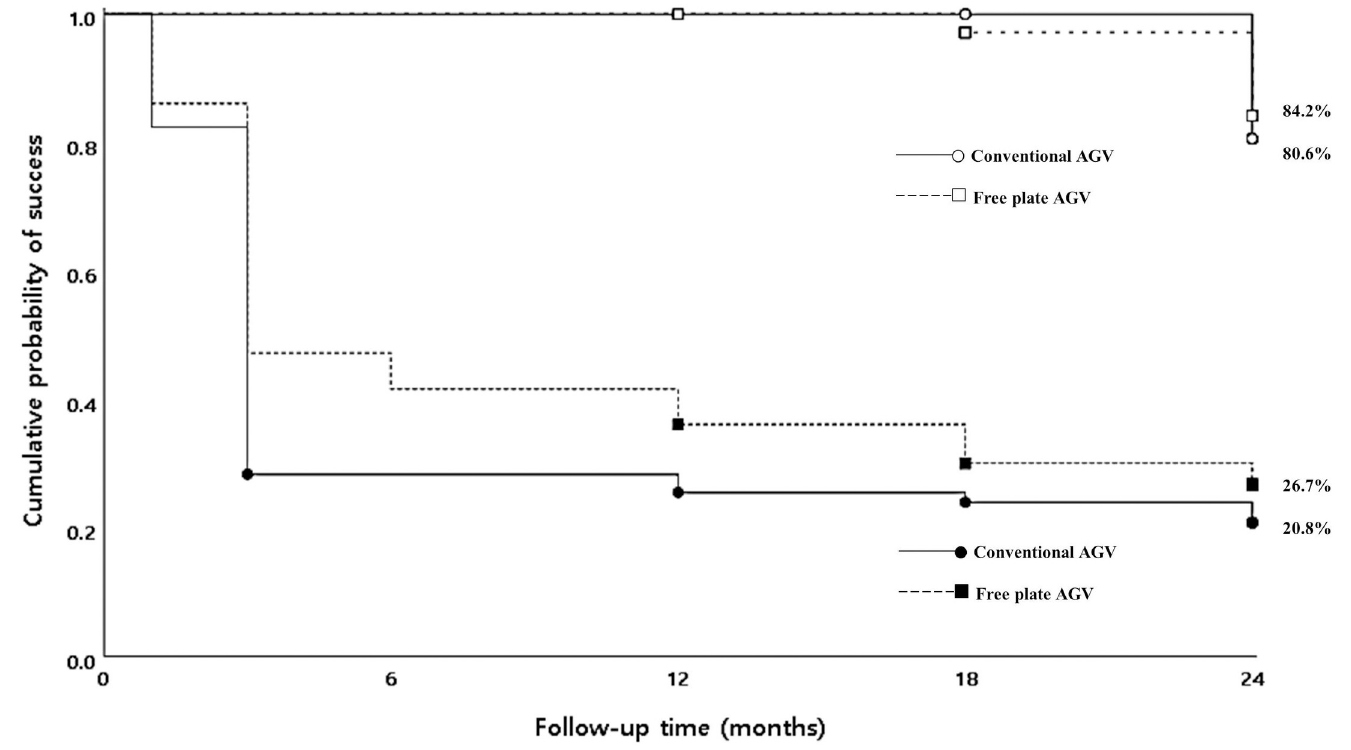
Fig 2. Kaplan–Meier survival curves showing the success rates of the conventional Ahmed glaucoma valve (CAGV) group and the free-plate Ahmed glaucoma valve (FPAGV) group. The survival rates were 80.6% in the CAGV group and 84.2% in the FPAGV group at 24 months (p = 0.367). The complete success rate were 20.8% in the CAGV group and 26.7% in the FPAGV group at 24 months (p = 0.354).